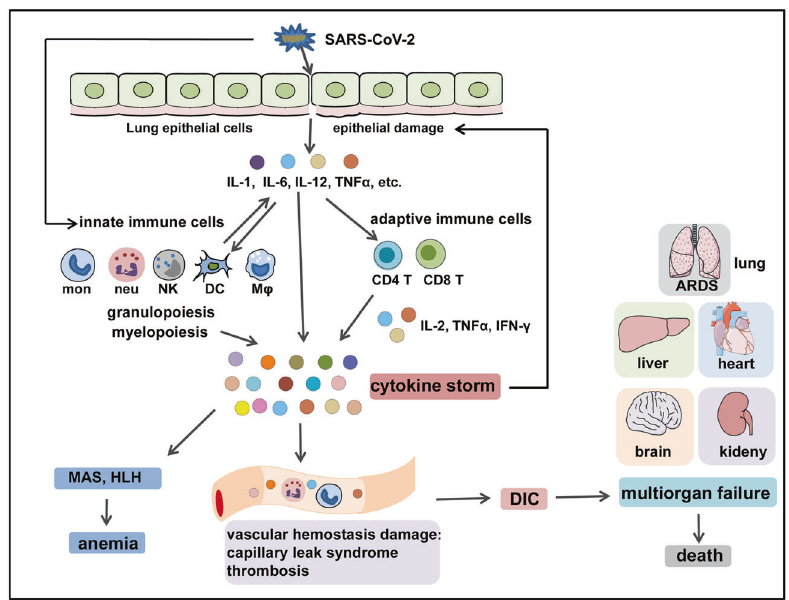
Fig. 4 The immunopathological mechanisms of COVID-CS. SARS-CoV-2 infects the epithelial cells or immune cells, causing tissue damage and release of in fl ammatory cytokines (e.g., IL-1, IL-6, IL-12, and TNF α ) by epithelial cells and immune cells. These in fl ammatory cytokines then recruit innate immune cells (monocytes, macrophages, neutrophils, DCs, and NK cells) and activate adaptive immune cells (CD4 + T cells and CD8 + T cells) to induce the occurrence of myelopoiesis and emergency granulopoiesis, as well as the production of sustained and excessive circulating cytokines that can further aggravate epithelial damage. In addition, overproduction of systemic cytokines triggers macrophage activation (i.e., MAS) and erythro-phagocytosis (i.e., HLH), resulting in anemia and gives rise to perturbation of vascular hemostasis, resulting in capillary leak syndrome, thrombosis, and DIC. These events together lead to ARDS, multiorgan failure, and death. HLH hemophagocytic lymphohistiocytosis, MAS macrophage activation syndrome, ARDS acute respiratory distress syndrome, DIC disseminated